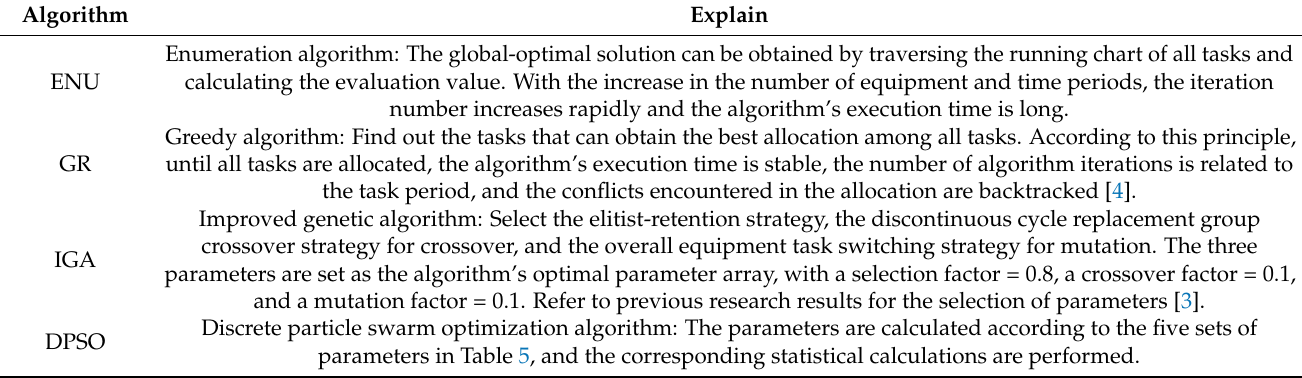
Table 6. DSTT comparison algorithm